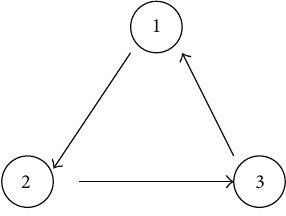
Figure 1: Graphic representation of the dependency digraph 𝐺 with vertex set 𝑉 = {1,2, 3} and arc set 𝐸 = {(1,2),(2, 3),(3,1)} .